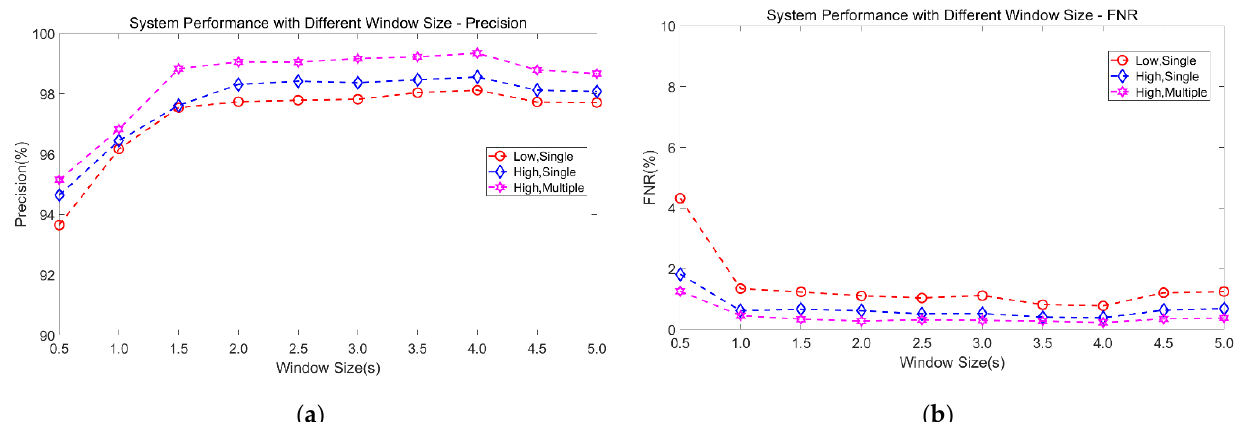
Figure 19. System performance with different window size. ( a ) Precision. ( b ) FNR.